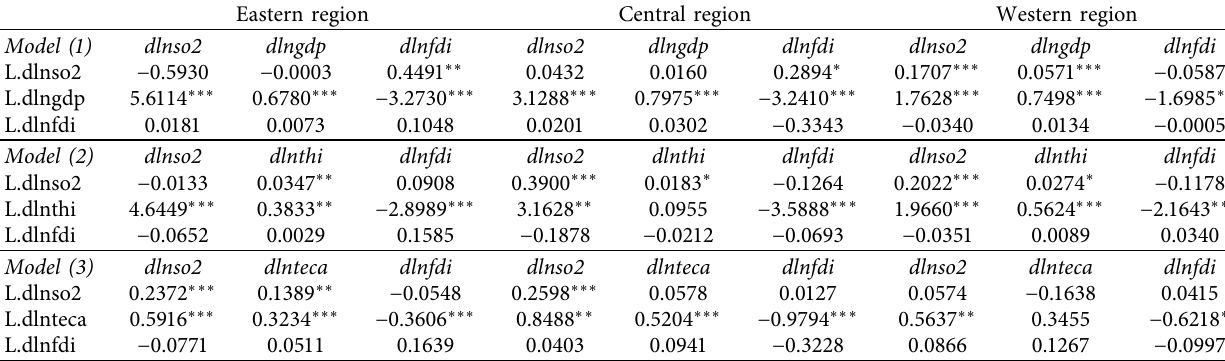
Table 8: The PVAR estimation results of each